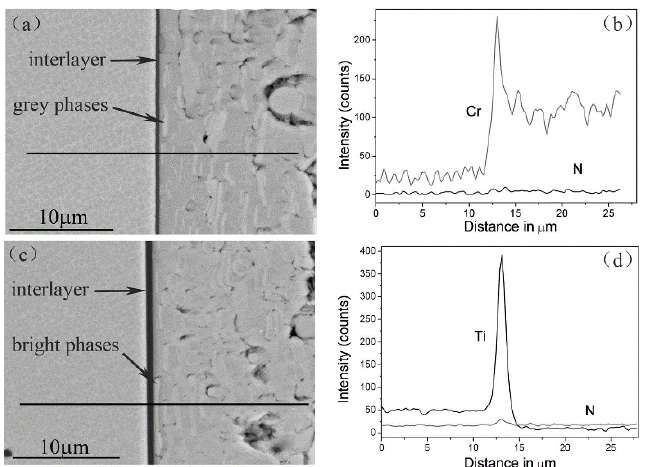
Figure 1. Cross-sectional BSE images ( a , c ) and elements depth profile ( c , d ) analyzed by EDX of the as-deposited K417/CrN/Ni+CrAlYSiN ( a , b ) and K417/TiN/Ni+CrAlYSiN ( c , d ) nano composite coating systems.